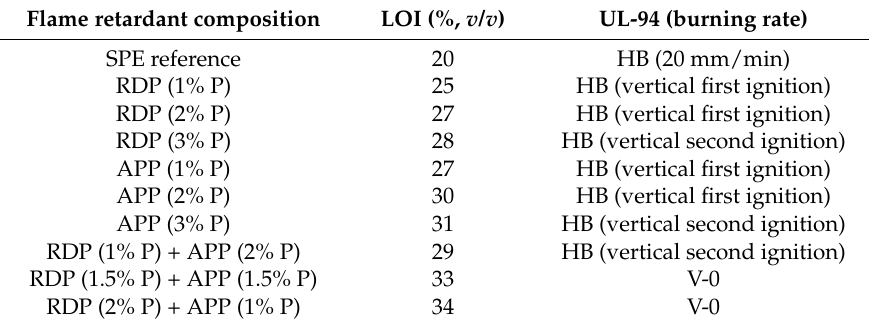
Table 2. Limiting oxygen index (LOI) and UL-94 results of the flame-retarded SPE samples. Flame retardant composition LOI (%, v/v ) UL-94 (burning rate) SPE reference 20 HB (20 mm/min) RDP (1% P) 25 HB (vertical first